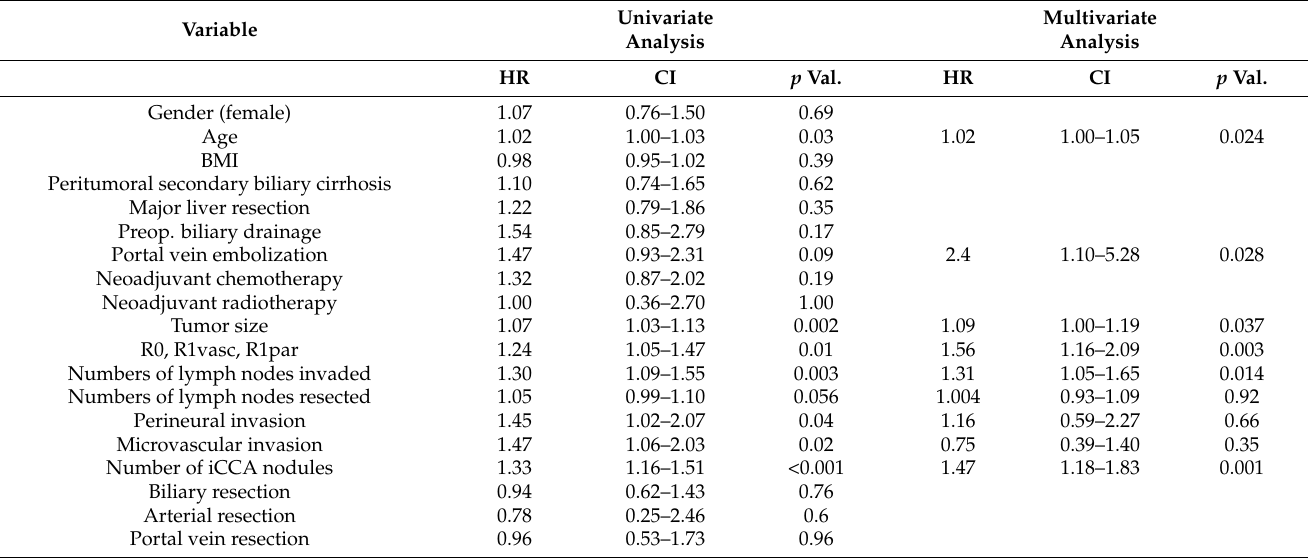
Table 4. Univariate and multivariate analysis for DFS.